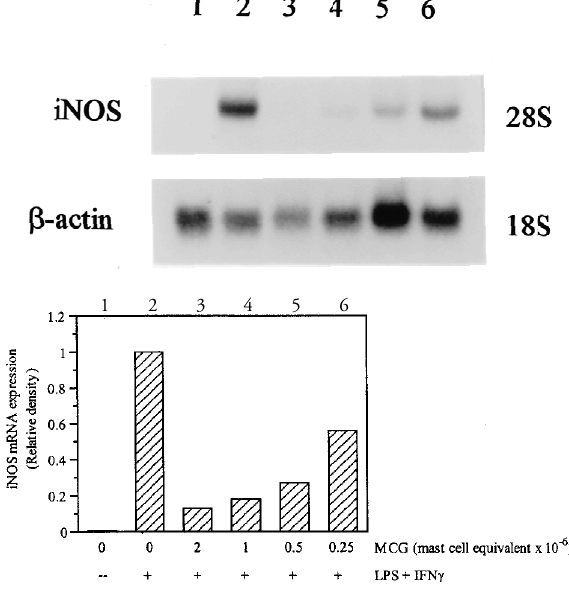
FIG. 1. Effect of MCG on macrophage iNOS mRNA expres- sion. Adherent macrophages (1 3 10 7 ) were exposed to the indicated doses of MCG (mast cell equivalent) and activated with LPS (100ng/ml) + IFN g (10units/ml). In all subsequent experiments the macrophages were activated with these concentrations. Eighteen hours after activation, iNOS and b -actin mRNA were analysed by Northern blotting. The b -actin expression was used to normalize the data. For top panel: lane 1. control; lane 2. LPS+IFN g ; lane 3. LPS+IFN g +MCG 2 3 10 6 ; lane 4. LPS+IFN g +MCG 1 3 10 6 ; lane 5. LPS+FN g +MCG 0.5 3 10 6 ; lane 6. LPS+IFN g +MCG 0.25 3 10 6 . This is representative of three experiments.